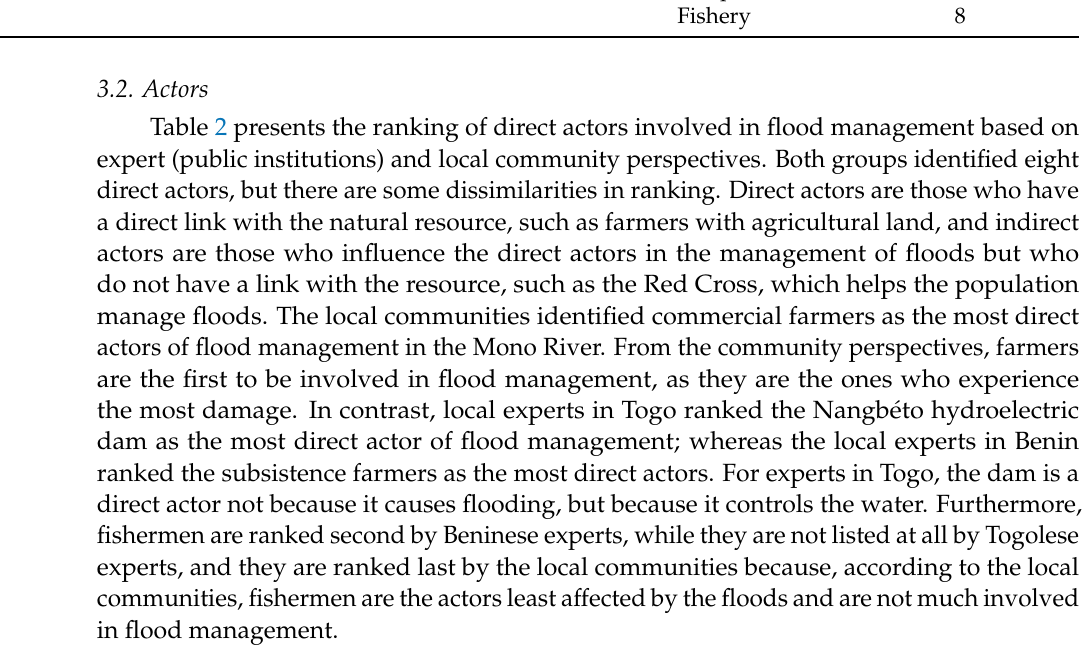
Table 2. Ranking of direct actors according to experts and local communities.